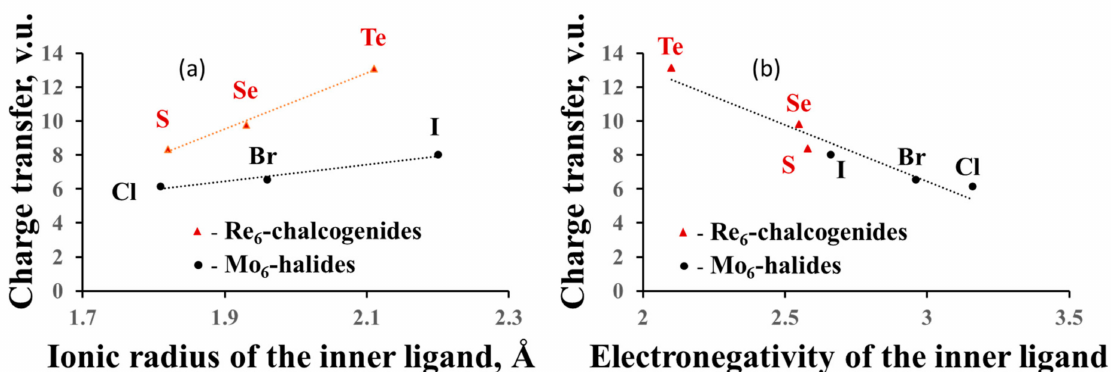
Figure 4. Charge transfer from the cluster to the ligands as a function of the size of the inner ligands ( a ) and the ligand electronegativity ( b ).